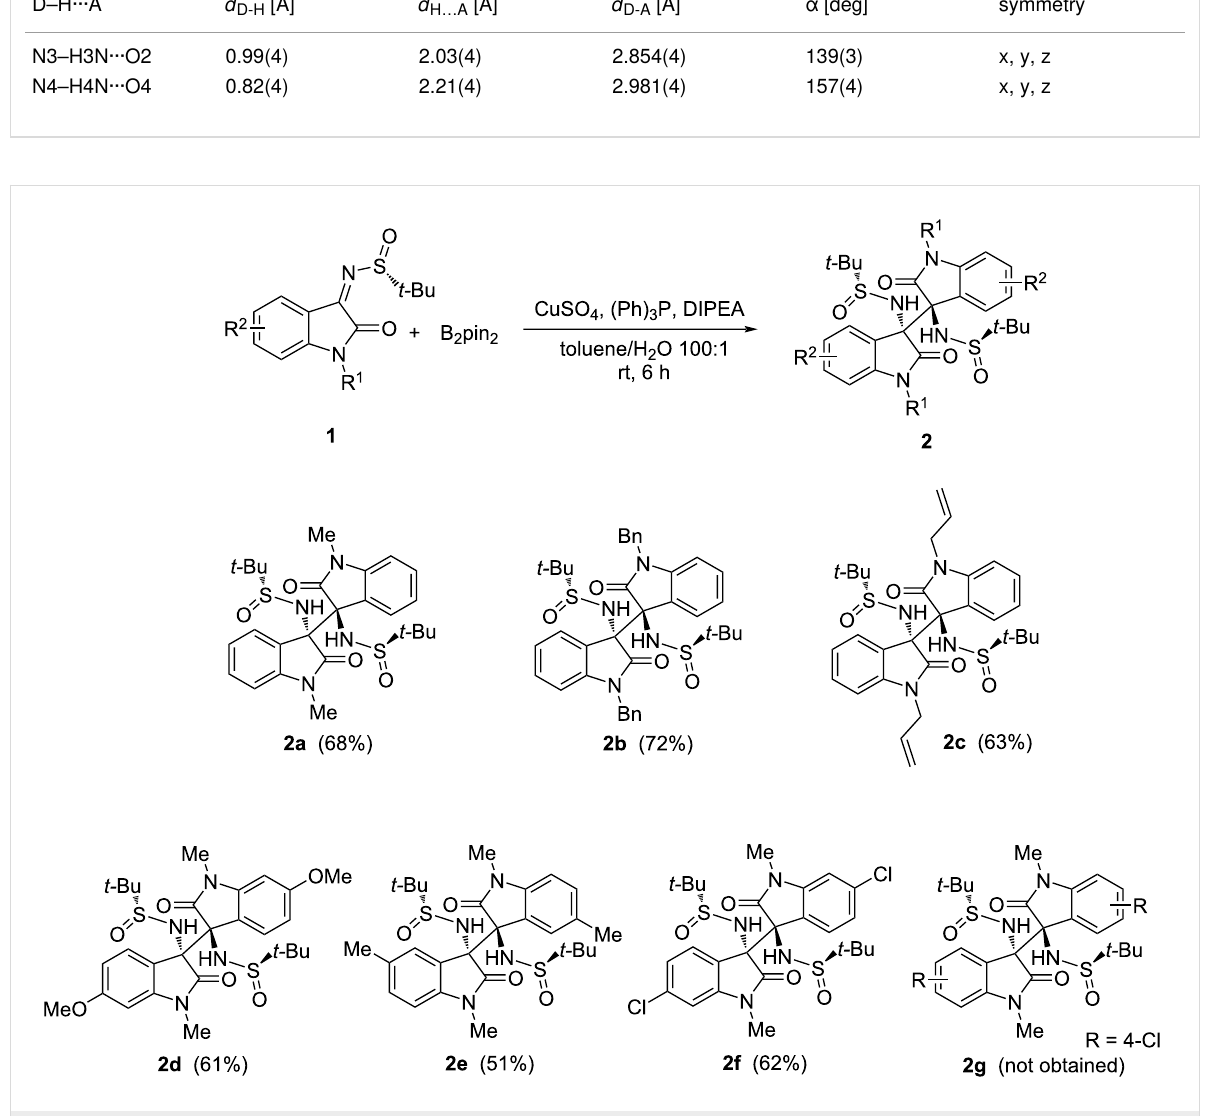
Figure 2: Substrate scope of the borylcopper-mediated homocoupling of oxindole-based N - tert -butanesulfinyl imines 1 (isolated yields in paren- theses).